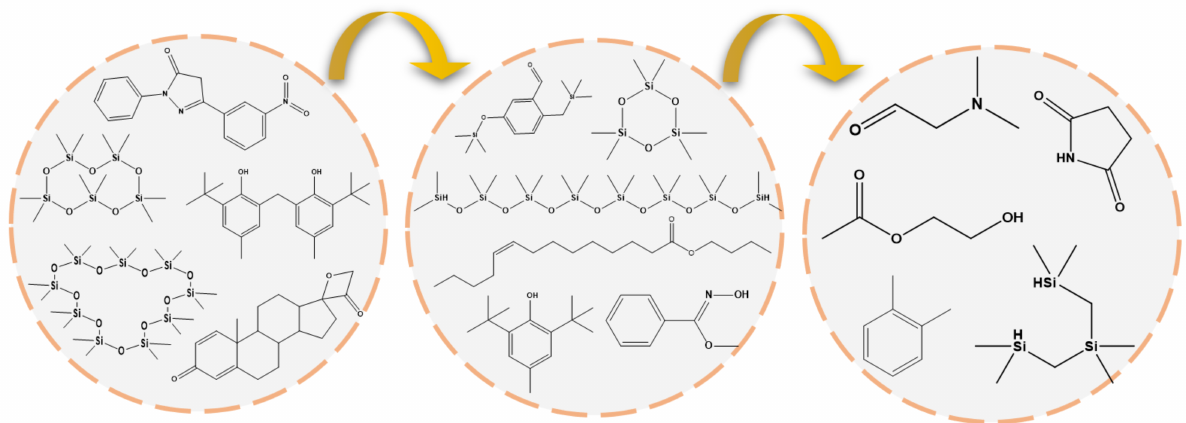
Figure 8. Proposed mineralization pathway followed by the main organic pollutants found in the actual pharmaceutical wastewater.